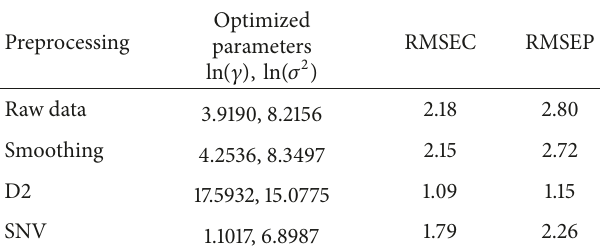
Table 1: The training and prediction results of LS-SVM with differ- ent data preprocessing